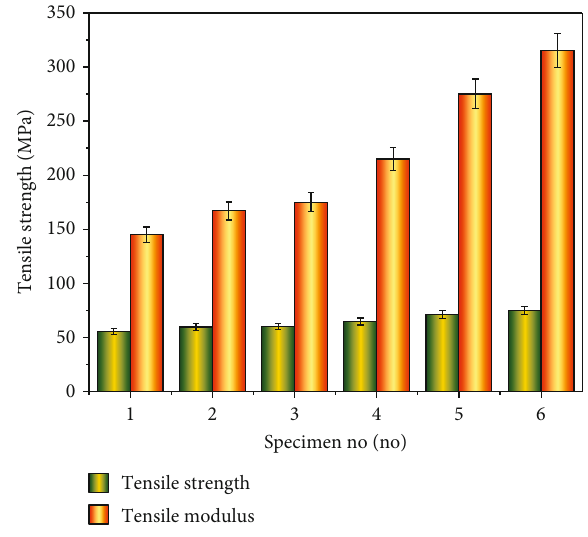
Figure 2: Tensile properties of coir/pineapple/Al based